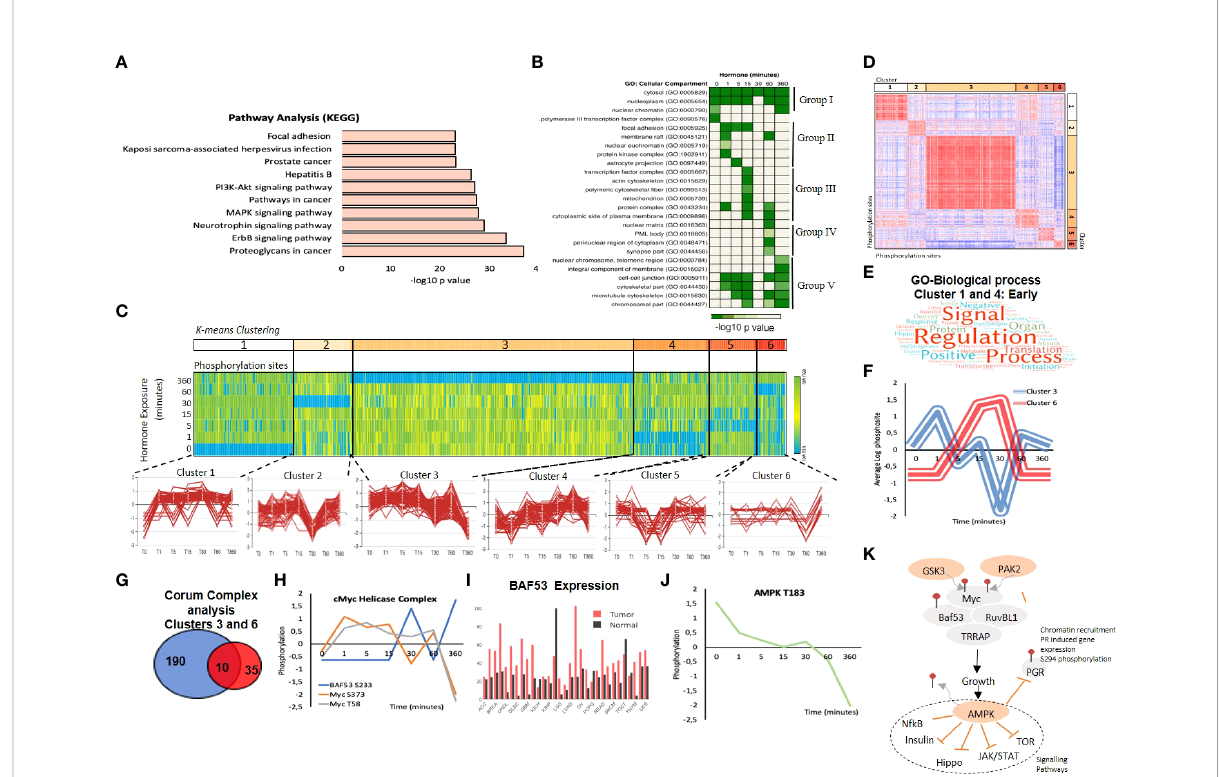
FIGURE 3 Combining Target Antibody Arrays and Shotgun Phosphoproteomic datasets following hormone. (A) KEGG pathway enrichment analysis of proteins identi fi ed as regulated by phosphorylation in response to hormone. (B) Cellular component analysis of phosphosites enriched per time point. Showing the hormone induced phosphorylation of the nucleoplasm and cytosol across all time points (group I) the activation of membrane raft proteins enriched at 1 minute (Group II) and phosphorylation of mitochondrial proteins enriched at 15 minutes (Group III), activation of nuclear structures; PML bodies and the nuclear matrix at 60 minutes (Group IV) and the activation of the cell-cell junctions and microtubules at 360 minutes (Group V). (C) K mean clustering of all signi fi cantly regulated phosphorylation sites over time reveals 6 distinct clusters. (D) Similarity matrix of clusters 1-6 reveals similar dynamics for clusters 1 and 4 and an opposing similarity in phosphorylation dynamics for clusters 3 and 6. Red indicates highly similar, well correlated, blue inversely correlated patterns of regulation. (E) Word cloud showing the enrichment of GO-biological processes associated with proteins identi fi ed in similar clusters 1 and 4 “ Early risers ” which are regulated rapidly after hormone. (F) Graph showing the opposing phosphorylation dynamic of proteins within clusters 3 and 6. (G) Venn diagram showing the overlap of signi fi cantly identi fi ed Corum protein complexes identi fi ed in clusters 3 and 6. (H) Phosphorylation dynamic in response to hormone of Myc S373, and T58 and BAF53 S233. (I) Expression level of BAF53 in tumor versus normal tissue within the TGCA dataset. (J) Phosphorylation of AMPL T183 decreases rapidly in response to hormone. (K) Model showing the key role of AMPK dephosphorylation in response to hormone in breast cancer cells, AMPK dephosphorylation is required in order for subsequent signalling cascades including NFkB, insulin, Hippo, JAK/STAT and mTOR to continue and the phosphorylation of PR S294 to take